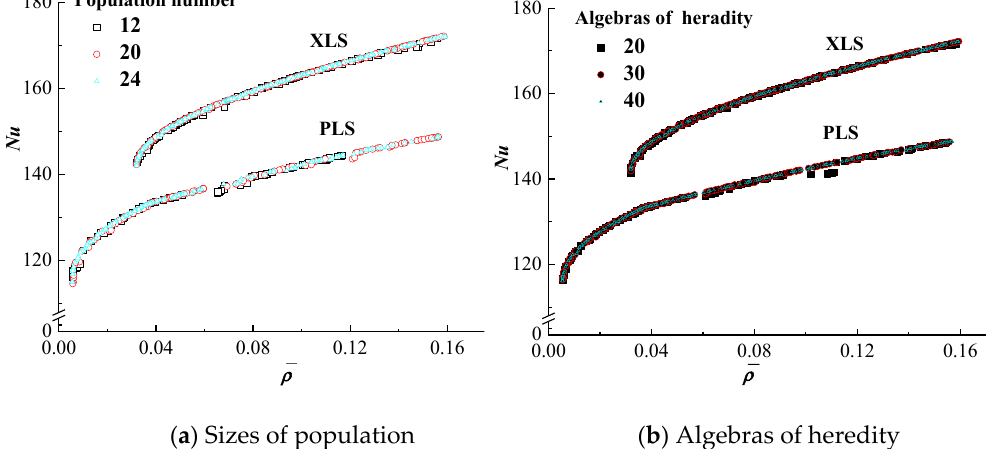
Figure 7. Influence of main parameters of genetic algorithm on the stability: ( a ) Sizes of population; and ( b ) algebras of heredity.